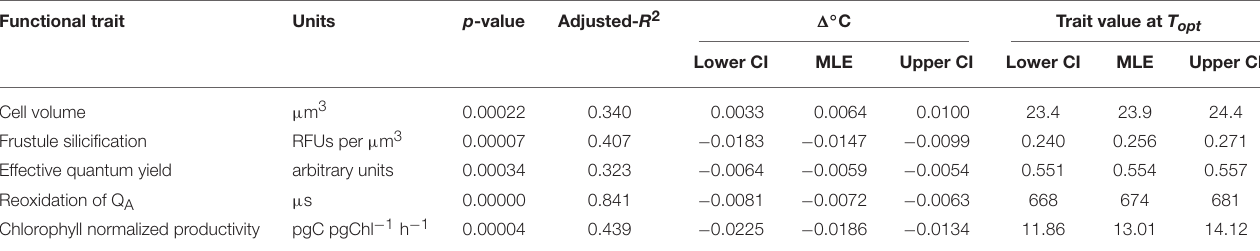
TABLE 2 | Estimated thermal reaction norm parameters for functional traits fitted using linear regression and associated uncertainty calculated by parametric bootstrapping, including: the proportional change in trait value per degree Celsius relative to the thermal optimum ( T opt ) for growth ( 1 ◦ C) and trait calue at thermal